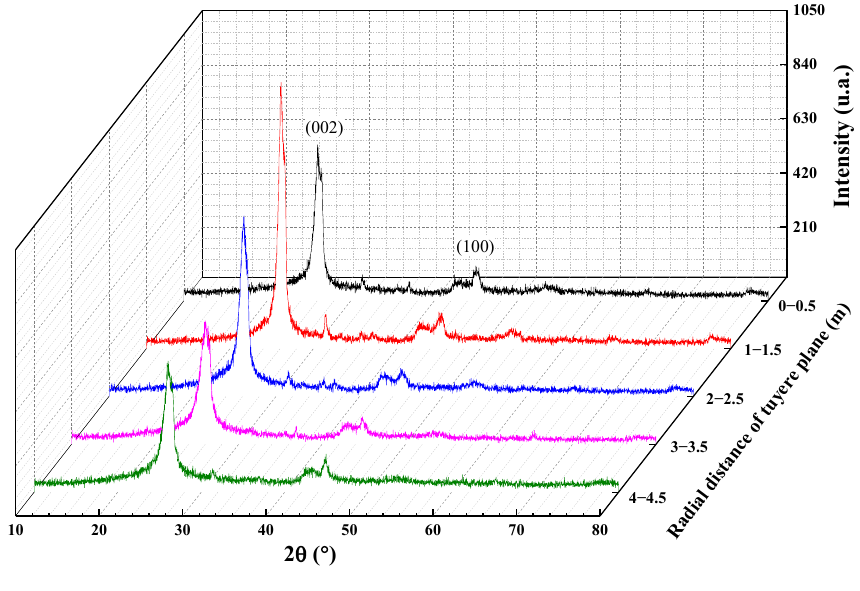
Figure 5. XRD patterns of TC.